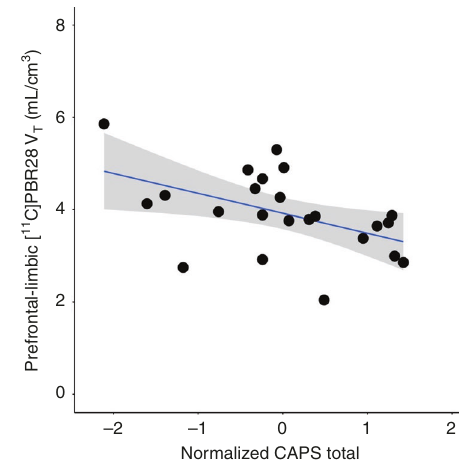
Fig. 1 Prefrontal-limbic TSPO availability was associated with PTSD severity. Lower [ 11 C]PBR28 V T was signi fi cantly associated with greater PTSD severity ( R 2 = 0.51, p = 0.003; β = − 0.43, p = 0.046), quanti fi ed by normalized total severity scores on CAPS in the PTSD group ( n = 23). Coef fi cient of determination and standardized coef fi cients were assessed using linear regression. Displayed composite prefrontal-limbic [ 11 C]PBR28 V T values are genotype- and sex-adjusted, with gray shading indicating 95% con fi dence intervals.